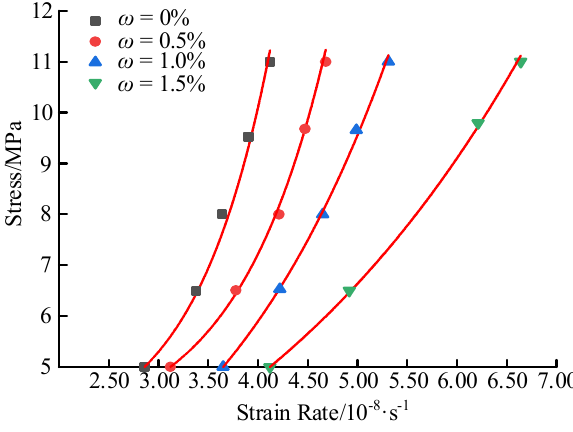
Figure 9. Stress–strain rate curve of coal and rock mass.